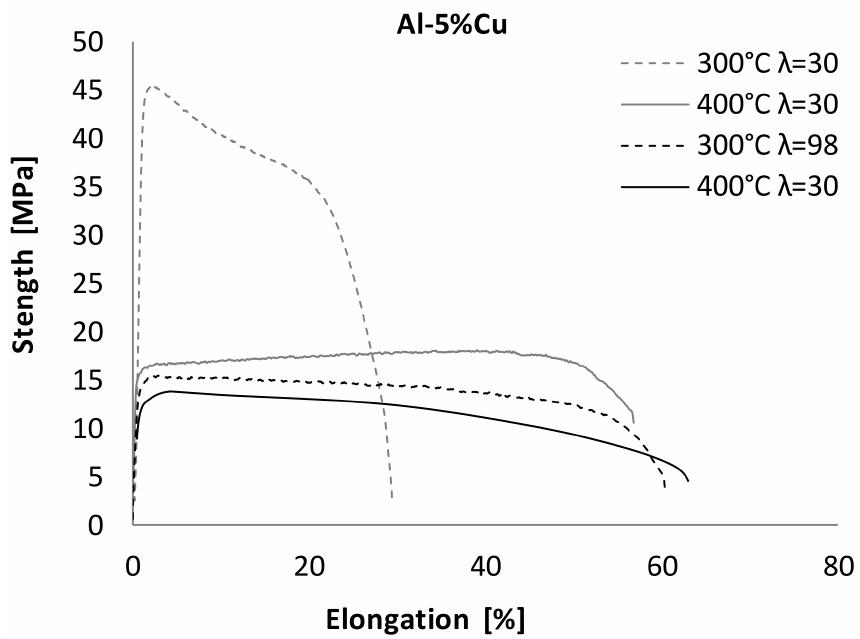
Figure 6. The superplastic tensile stress–strain curves for Al 5 Cu